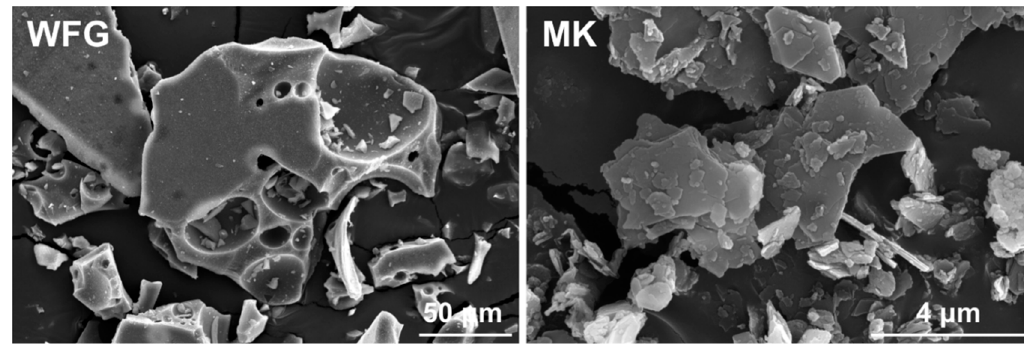
Figure 5. SEM micrographs of the raw materials (WFG and MK).